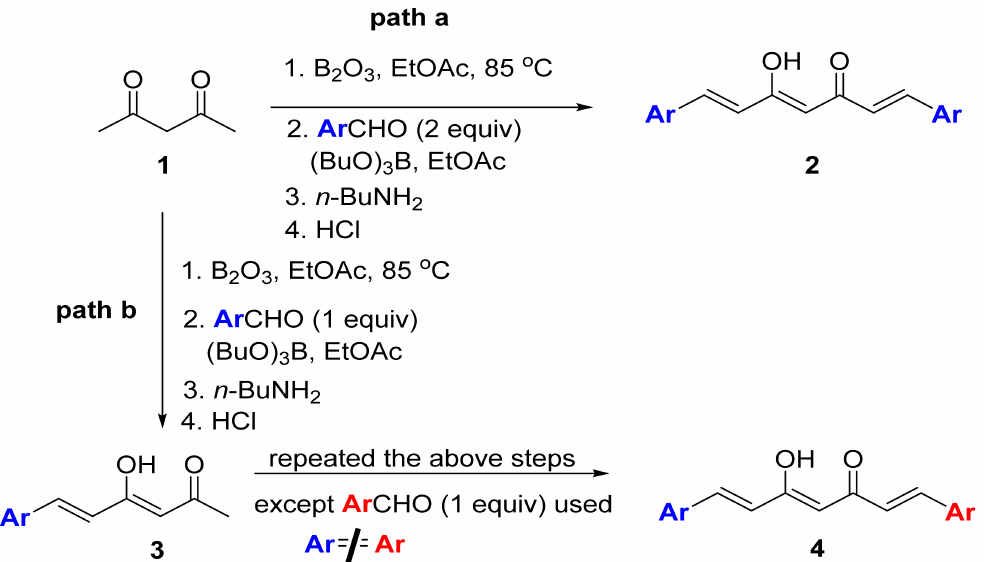
Figure 3. General procedure of Pabon’s method for the synthesis of symmetric and asymmetric